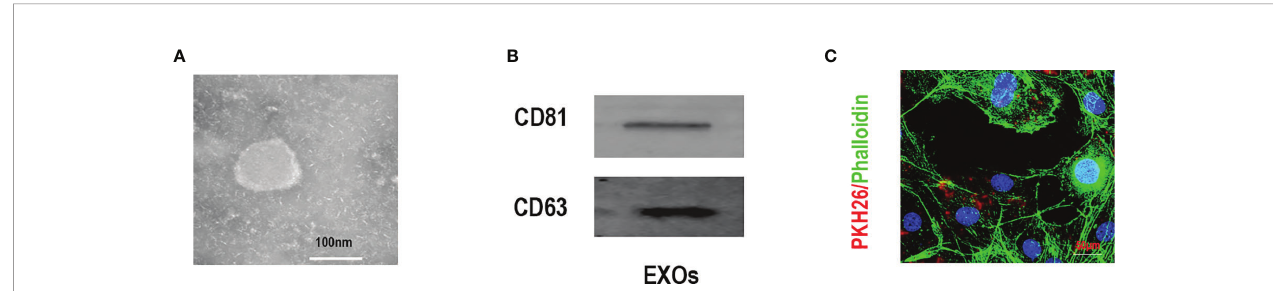
FIGURE 1 | Characterization of exosomes derived fromBMSCs. (A) Morphology identi fi ed by TEM, scale bar:100 nm. (B) The speci fi c surfacebiomarkersof exosomes were analyzed byWesternblotting assay. (C) The exosomes derived from BMSCs were marked with PKH26 and co-cultured with C2C12 myotubes, mbar = 50 m